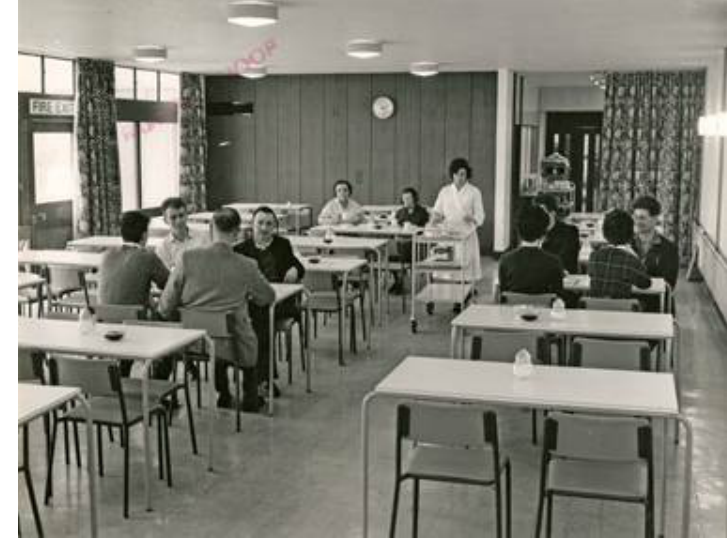
Figure 10. Post-war Admission Villa, Fulbourn Hospital, Cambridgeshire, dining room, 1964 (Source: ‘Photographs taken at the opening of Kent House by Princess Marina, Duchess of Kent, 1964’, KHF/6/1/15, Cambridgeshire Archive Services, Ely, Cambridgeshire,